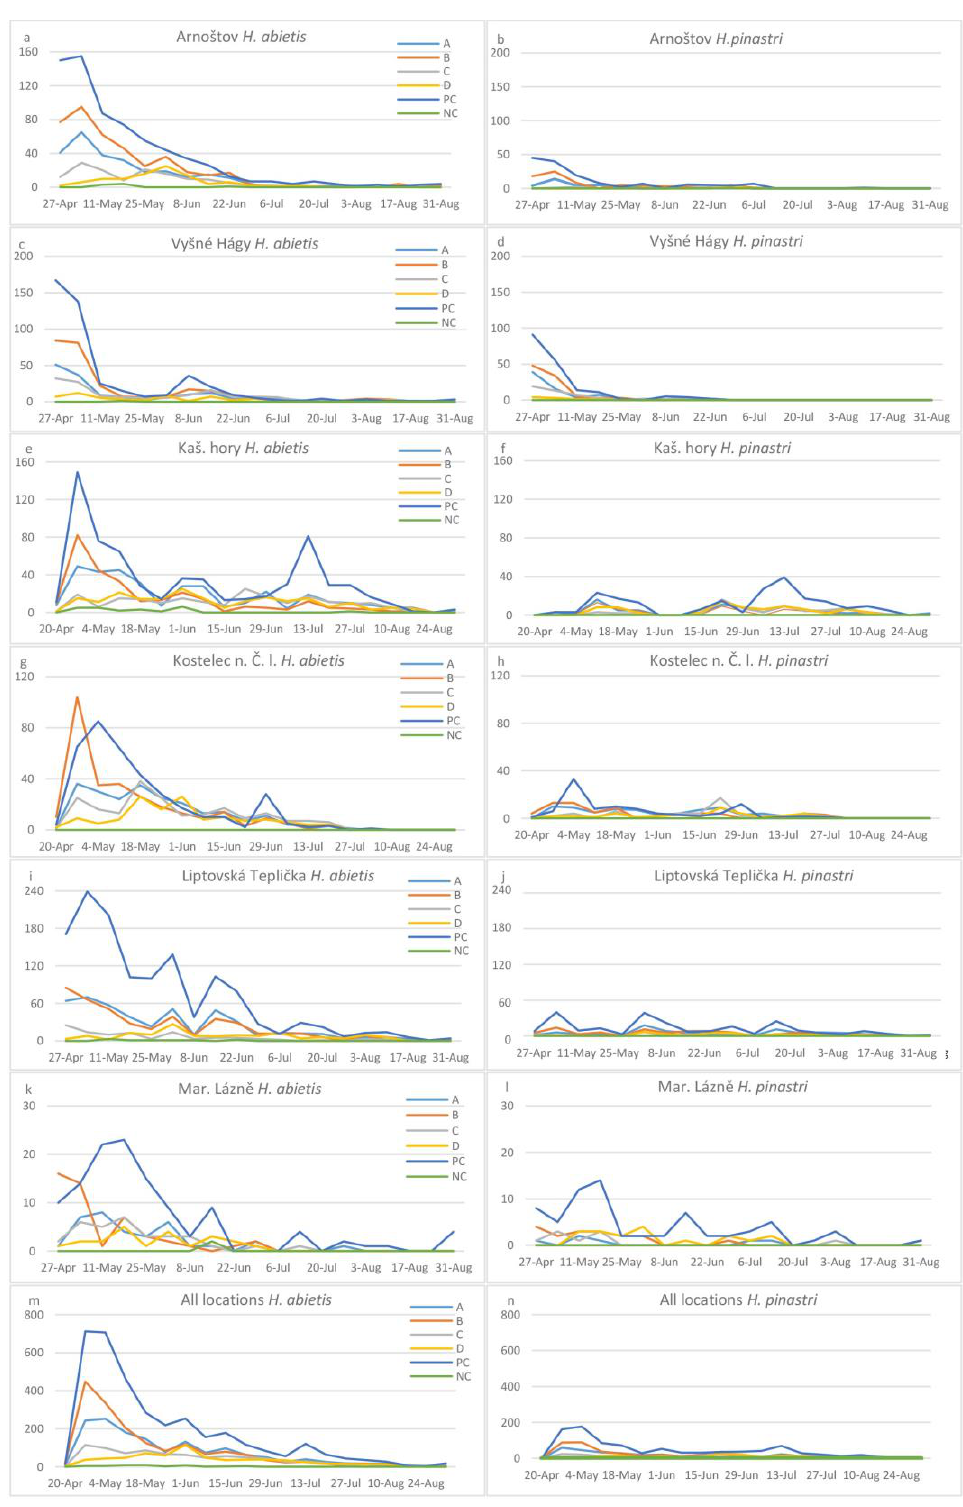
Figure 6. Mean numbers of H. abietis (a, c, e, g, i, k, m) and H. pinastri (b, d, h, j, l, n) adults trapped over time as affected by attractant and locality .